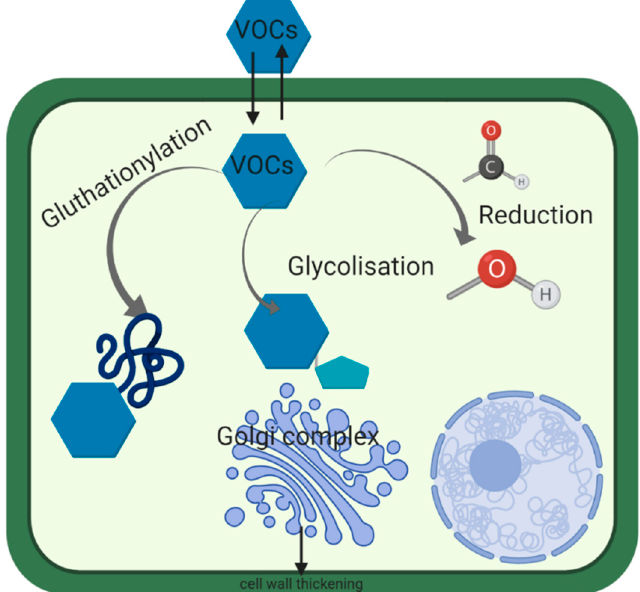
Figure 2. Sequestration and biotransformation of exogenous volatile organic compounds (VOCs) in plant.